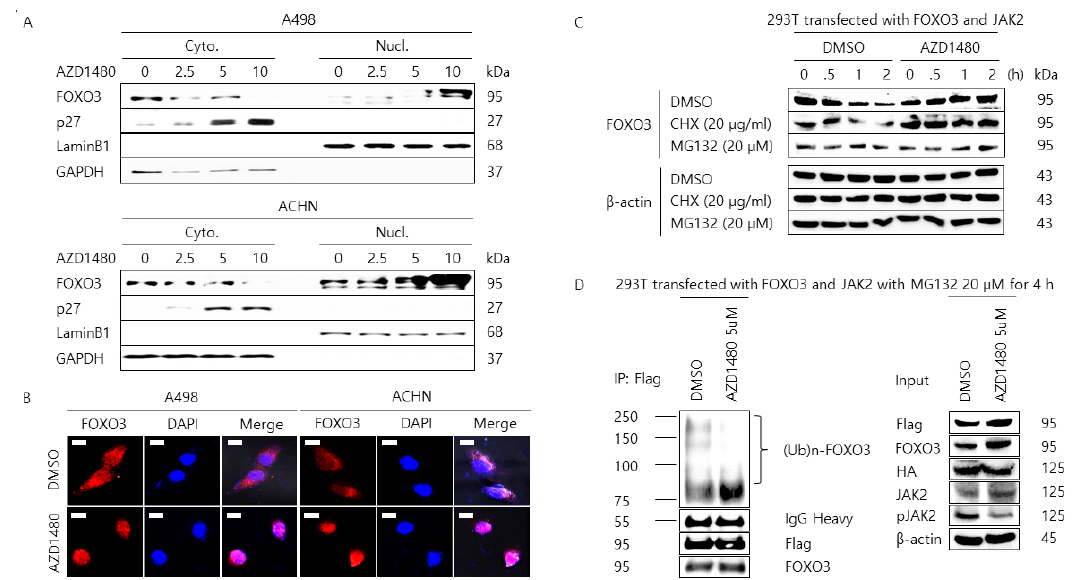
Figure 4. The nuclear localization of FOXO3 by inhibition of JAK2. ( A ) Cells were treated with DMSO vehicle control or the indicated concentration of AZD1480 (0, 2.5, 5, and 10 μ M) for 48 h, washed with PBS, trypsinized, and lysed in the cytoplasmic fractional buffer. After separating the cytoplasmic fraction, the remaining pellet was washed with washing buffer and lysed with nuclear fractional buffer, and the supernatant was collected for the nuclear fraction. Glyceraldehyde 3-phosphate dehydrogenase (GAPDH) and Lamin B1 were used for a gel loading control for the cytoplasmic and nuclear protein fractions, respectively. ( B ) Pharmacological inhibition of JAK2 induces the nuclear localization of FOXO3 in A498 and ACHN. Cells were treated with DMSO vehicle control or AZD1480 (5 μ M) for 2 h and then incubated with a primary antibody against FOXO3 followed by Alexa 594-conjugated anti-mouse secondary antibody. The nuclei were counterstained by 4 ′ ,6-diamidino-2-phenylindole (DAPI). Fluorescence images were captured with a confocal microscope. Scale bar: 5 μ m ( C ) Pharmacological inhibition of JAK2 increases the protein stability of FOXO3 in 293T cells transfected with pECE Flag-FOXO3 and pCMV3-C-HA- JAK2 plasmid DNA via a proteasome-mediated pathway. Next, 293T cells were treated with DMSO (control vehicle), cycloheximide (CHX, 20 μ g/mL), or MG-132 (20 μ M) with/without AZD1480 (5 μ M) for the indicated time and then cell lysates were resolved on the SDS-PAGE and immunoblotted by the anti-FOXO3 antibody. β -actin was used for the loading control. ( D ) Pharmacological inhibition of JAK2 decreases the ubiquitination of FOXO3 in 293T cells transfected with pECE Flag-FOXO3 and pCMV3-C-HA-JAK2 plasmid DNA. 293T cells were treated with DMSO (control vehicle) or MG132 (20 μ M) with/without AZD1480 (5 μ M) for the indicated time and then cell lysates were immunoprecipitated with anti-FOXO antibody and blotted with anti-ubiquitin, Flag, and FOXO3 antibody. The heavy chain of IgG was used for the loading control. For input analysis, cell lysates were resolved on the SDS-PAGE and immunoblotted by anti- JAK2, pJAK2, and FOXO3 antibody. β -actin was used for the loading